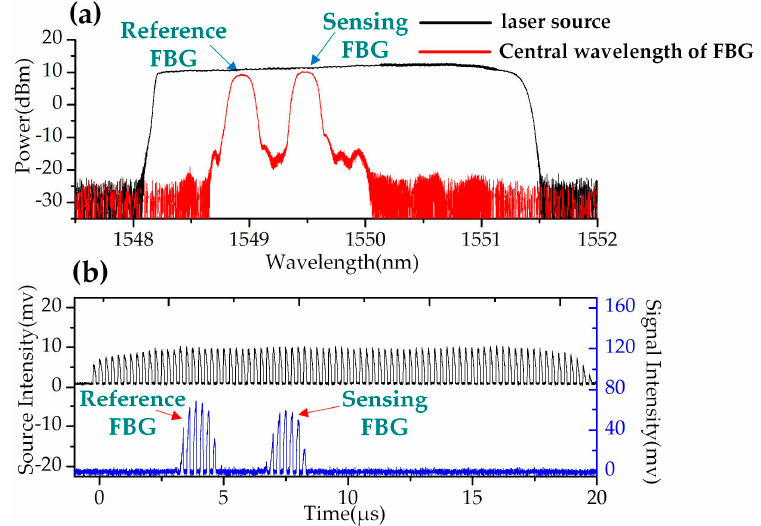
Figure 9. The reflection spectrum of reference and sensing FBGs in ( a ) the wavelength domain and ( b ) the time domain.